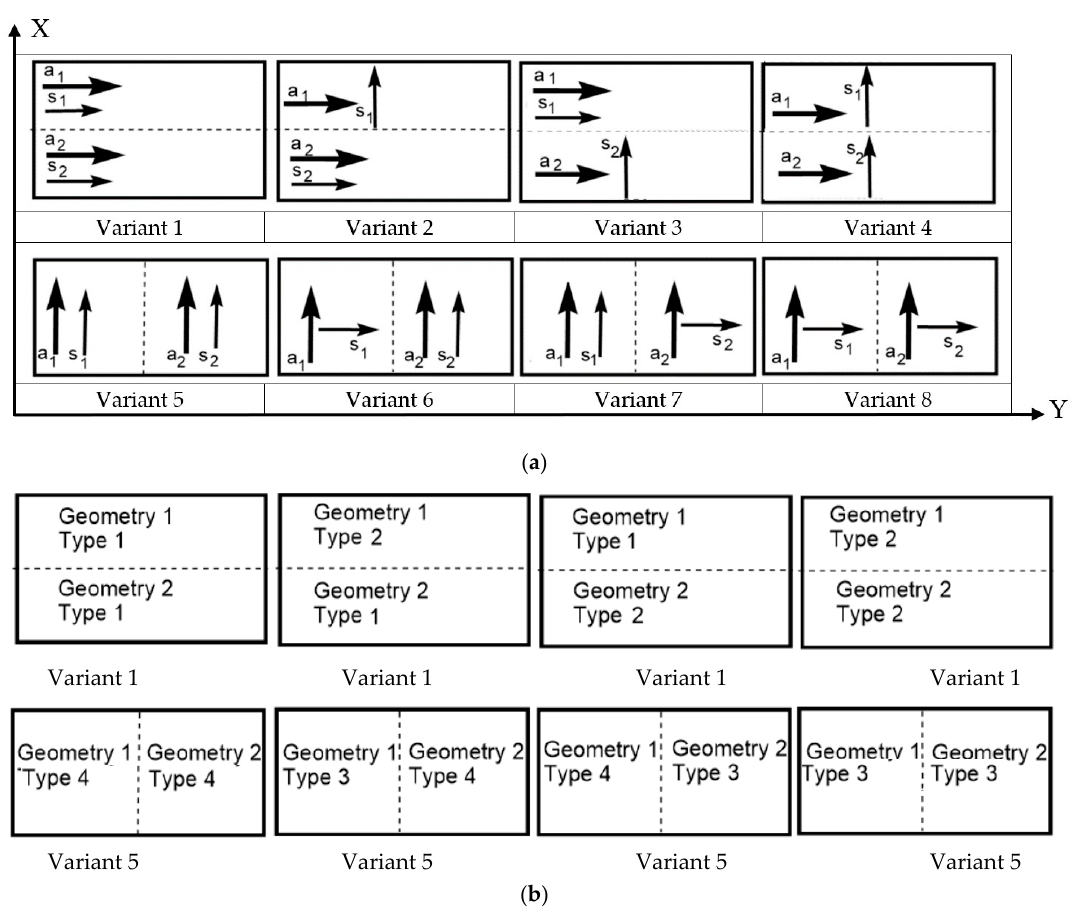
Figure 10. Variants for the combination of two sections: ( a ) in terms of arrows a and s; ( b ) in terms of types of sections and geometries.